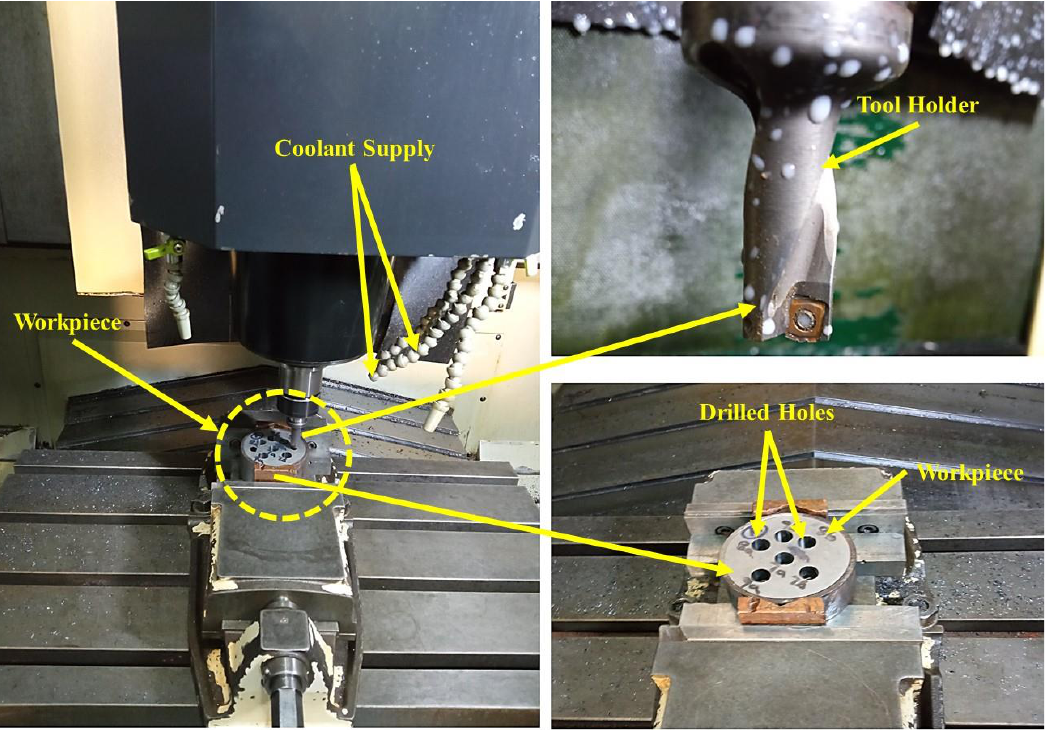
Figure 3. Experimental setup on the vertical machining center showing the workpiece and cutting inserts mounted on the tool holder.